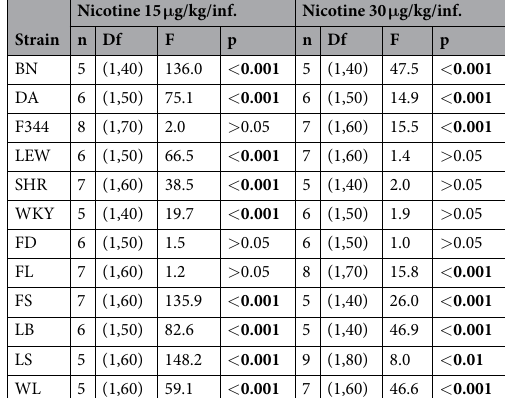
Nicotine 15 μ g/kg/inf.